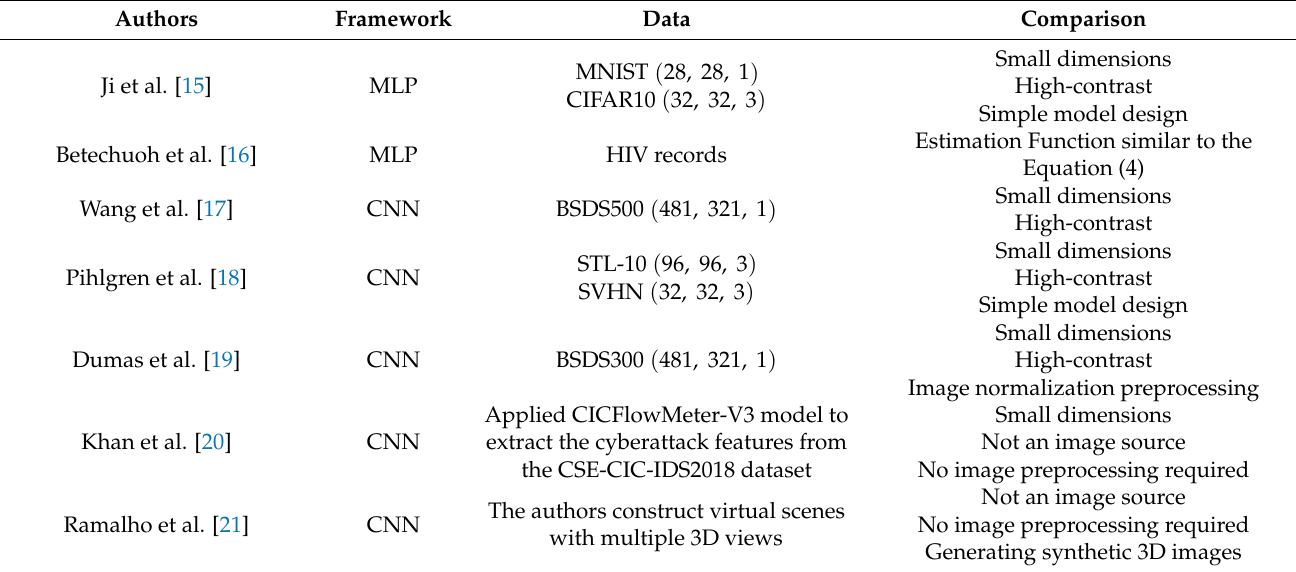
Table 1. Autoencoder model comparison with the previous